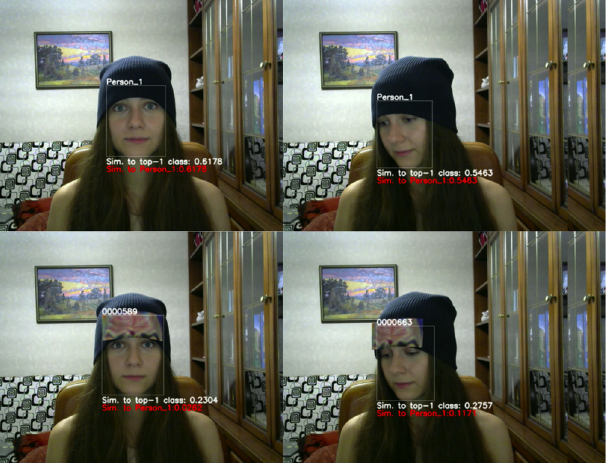
Figure 2. AdvHat can launch an attack on facial recognition systems in the form of a hat.